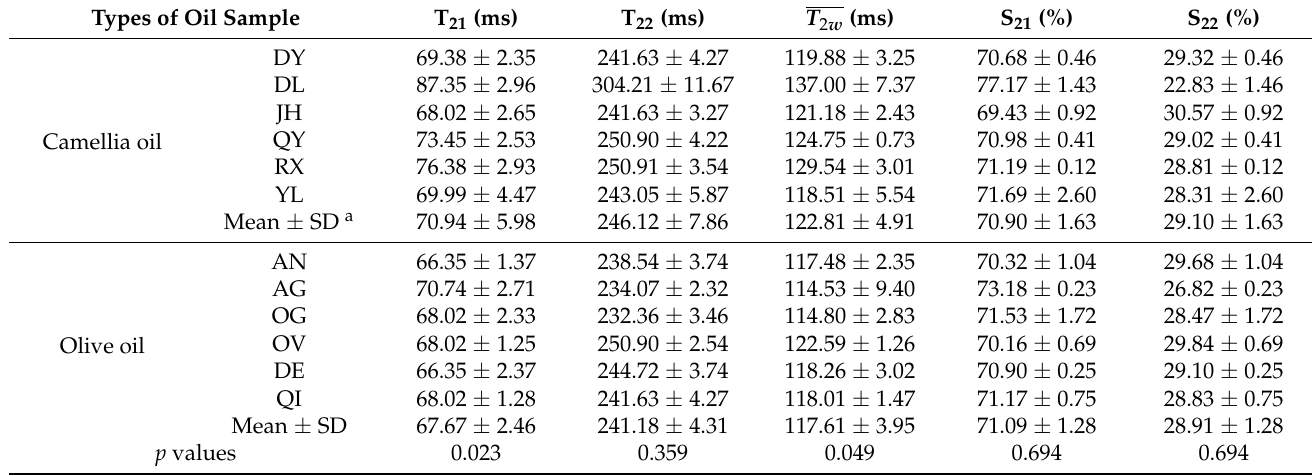
Table 2. T 2 distribution parameters of camellia oil and olive oil.